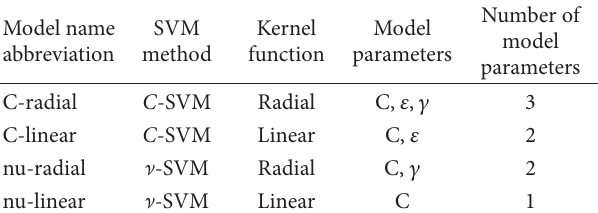
Table 2: Models and their